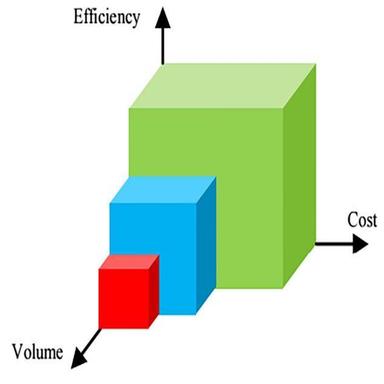
The relationships between volume, efficiency, and cost.